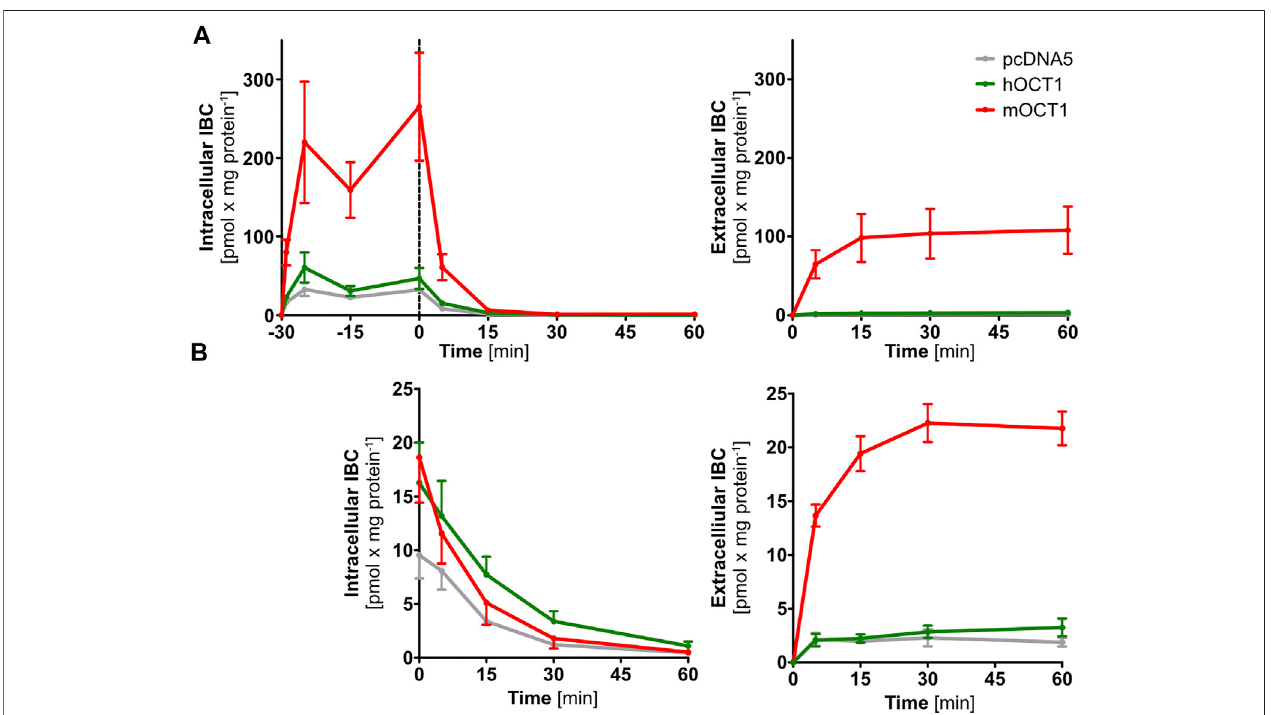
FIGURE 4 | Time-dependent isobutyrylcarnitine ef fl ux. Absolute ef fl ux of IBC without (A) and with (B) adjustment of preloading IBC concentrations revealed IBC ef fl ux capabilities of mOCT1 but not hOCT1. In the upper right part, intracellular concentrations are shown during the course of preloading and then, after stop of preloadingbychangingthemedia,theef fl uxisshown.Intheotherthree fi gures,onlytheef fl uxphaseisshown.Dataarerepresentedasthemean ± SEMandresultfrom at least three independent